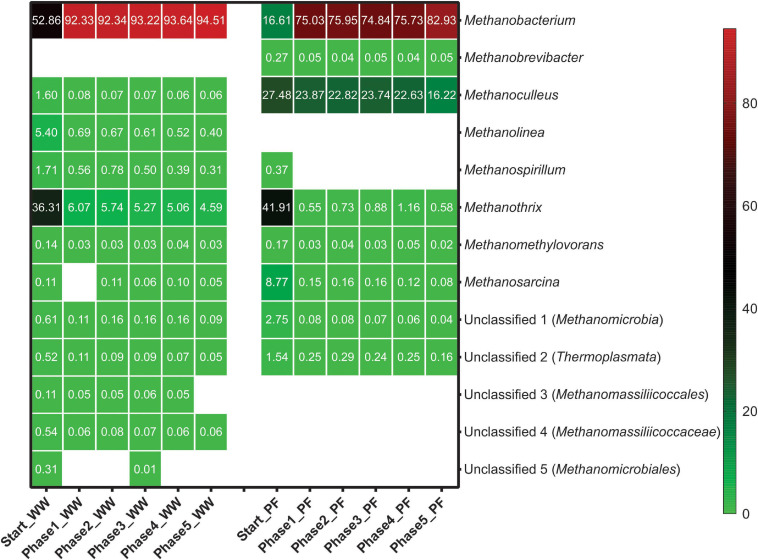
Methanogenic community structure based on mcrA gene amplicon sequencing in different phases at genus level. Taxa with relative abundances less than 0.1% were filtered out. Numbers represent the relative abundance in percent and blank space indicates the absence of the respective taxon. Mean values of three biological replicates are presented for Start whereas four biological replicates were averaged for phase 1–5. WW: reactors (inoculated with anaerobic granular sludge from an industrial-scale UASB reactor treating wastewater from paper industry) and PF: reactors (inoculated with digestate from a pilot-scale plug-flow reactor digesting cow manure and corn silage).